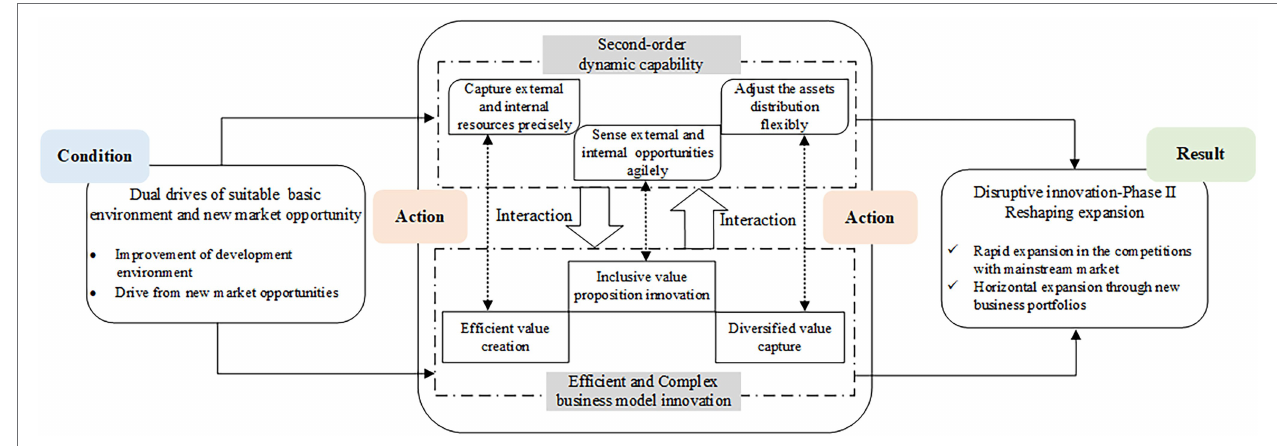
FIGURE 2 | The happening mechanism of ByteDance’s reshaping expansion